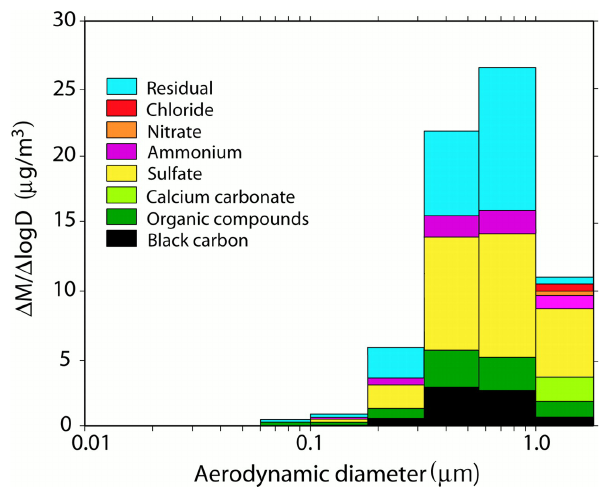
Fig. 25. Average mass ( M ) composition of the aerosol observed at the Kaashidhoo Climate Observatory (KCO) during February 1999, as a function of the particle size. The residual includes mineral dust, fly ash, and unknown compounds (from Lelieveld et al., 2001, copyright 2001 by the American Association for the Advancement of Science, reproduced with